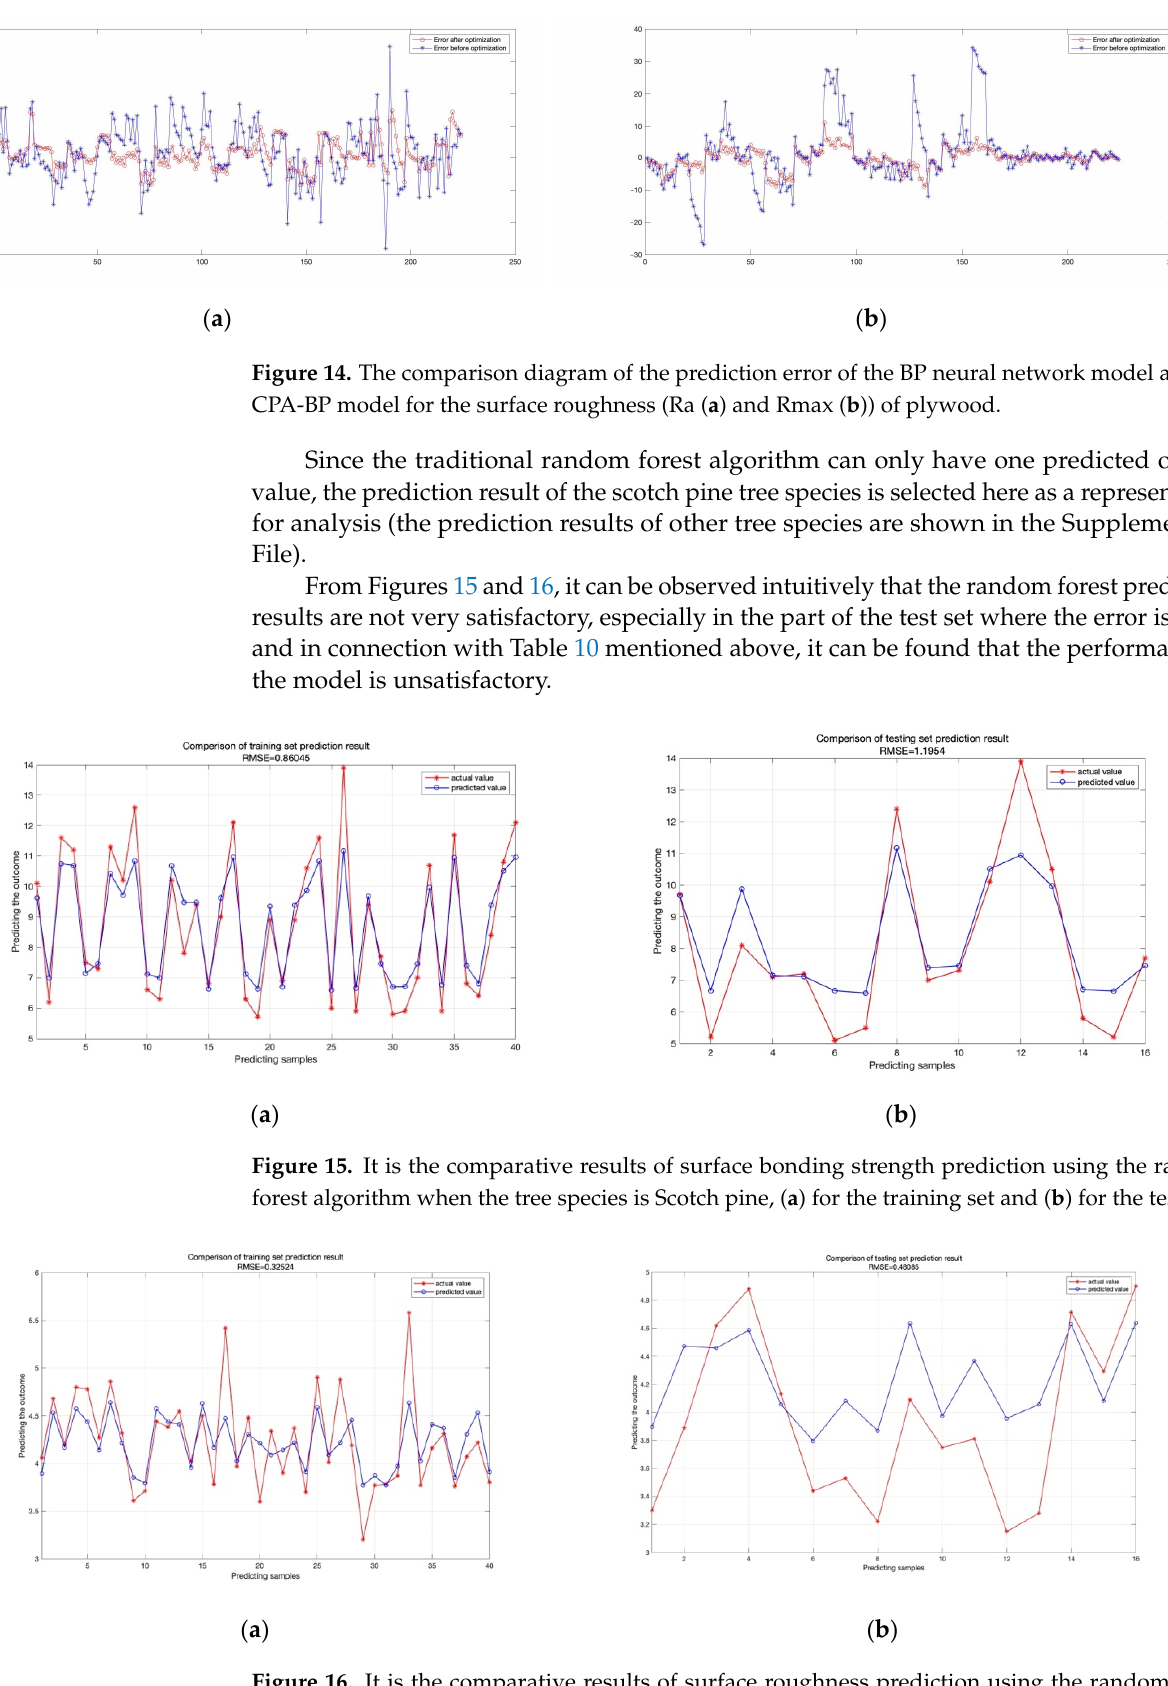
predicted value of the BP ( a ) and the CPA-BP ( b ) model is shown in Figure 13.